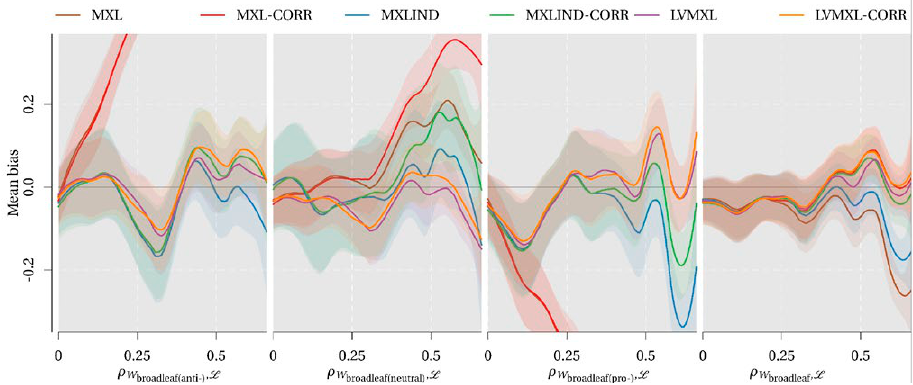
Figure 5. Mean bias in MWTP broken down by anti-, neutral and pro-environmental tendencies for